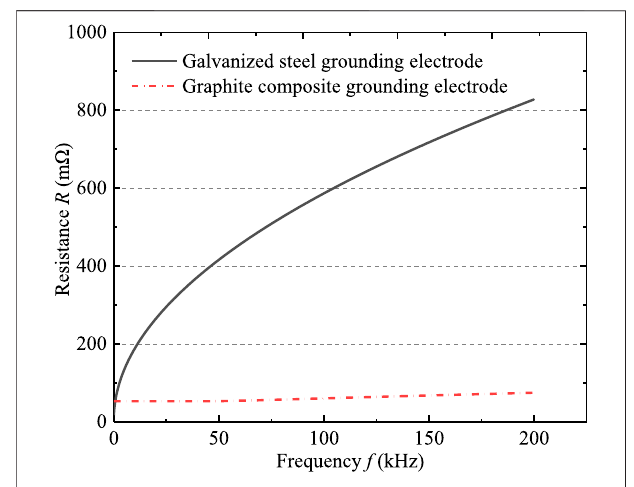
FIGURE 10 | Effect of frequency on grounding electrode